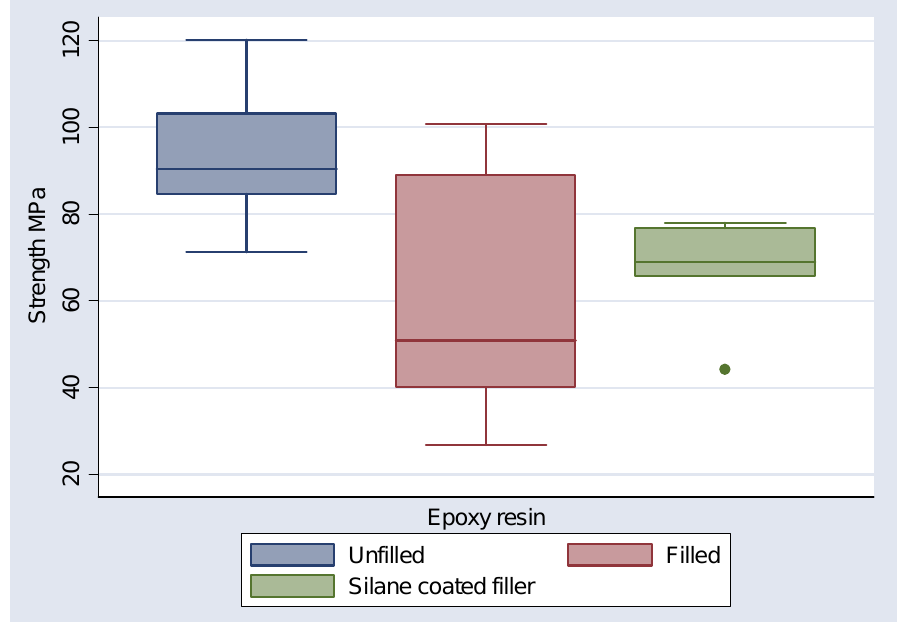
Figure 6. Boxplot of observed strengths (MPa) of epoxy resin in each of three states, unfilled, filled and with silane coated